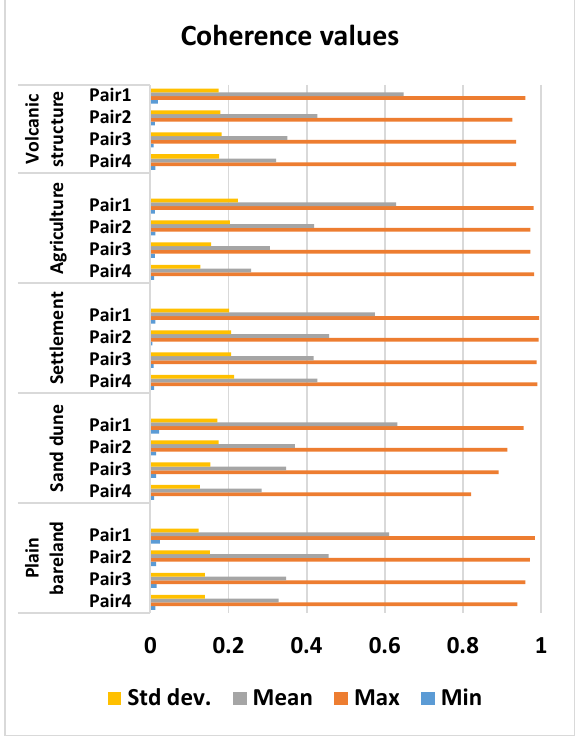
Figure 4. Descriptive statistics of coherence values of the pairs